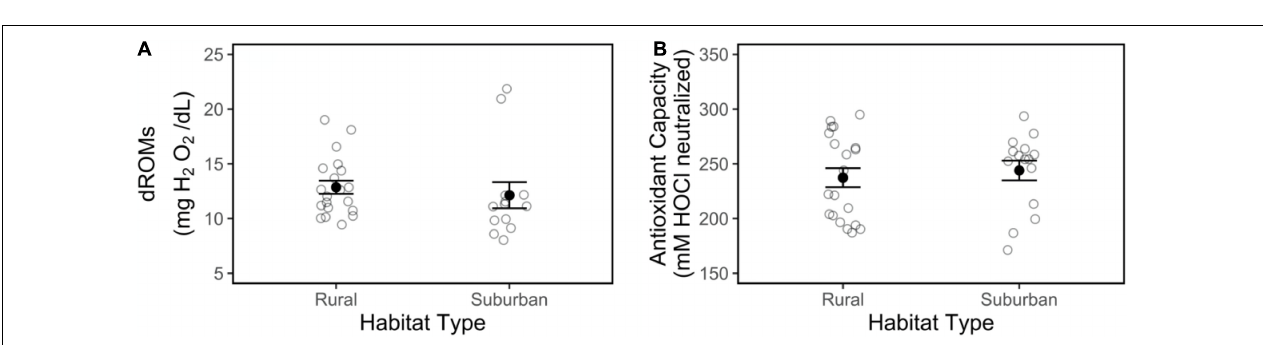
FIGURE 3 | Total glutathione (tGSH; A ), free glutathione (GSH; B ), oxidized glutathione (GSSG; C ) concentrations and the ratio of GSSG:tGSH (D) in blood collected from male song sparrows inhabiting rural and suburban sites. Closed circles and whiskers are mean ± SE; open circles are measurements of individuals birds. No significant habitat differences were